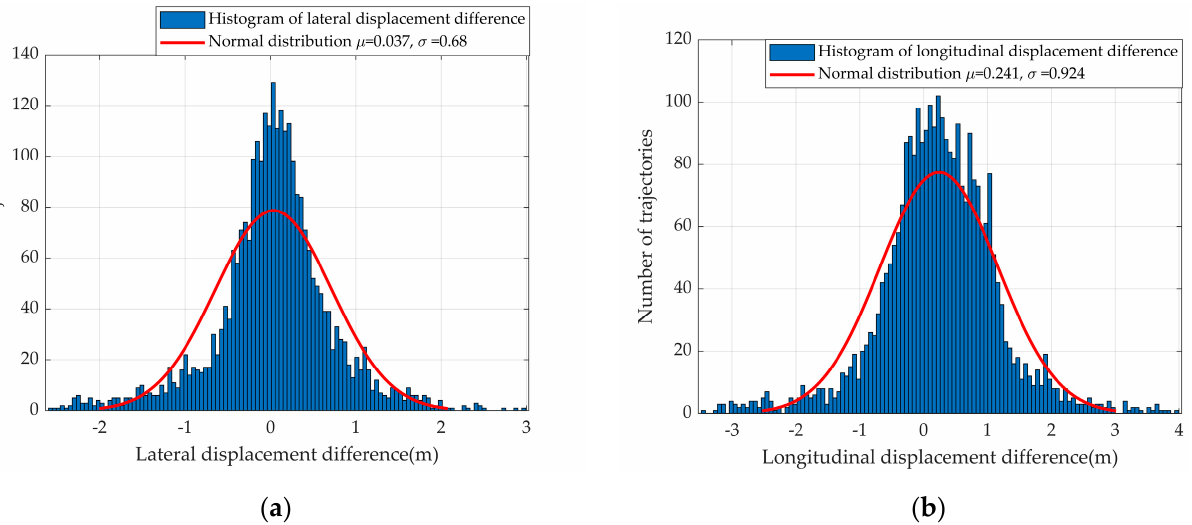
Figure 8. ( a ) The histogram of lateral displacement difference with fitted normal distribution. ( b ) The histogram of longitudinal displacement difference with fitted normal distribution. Figure 9 describes the displacement distribution in both lateral and longitudinal directions. It can be seen that the displacement difference distributes around (0, 0).